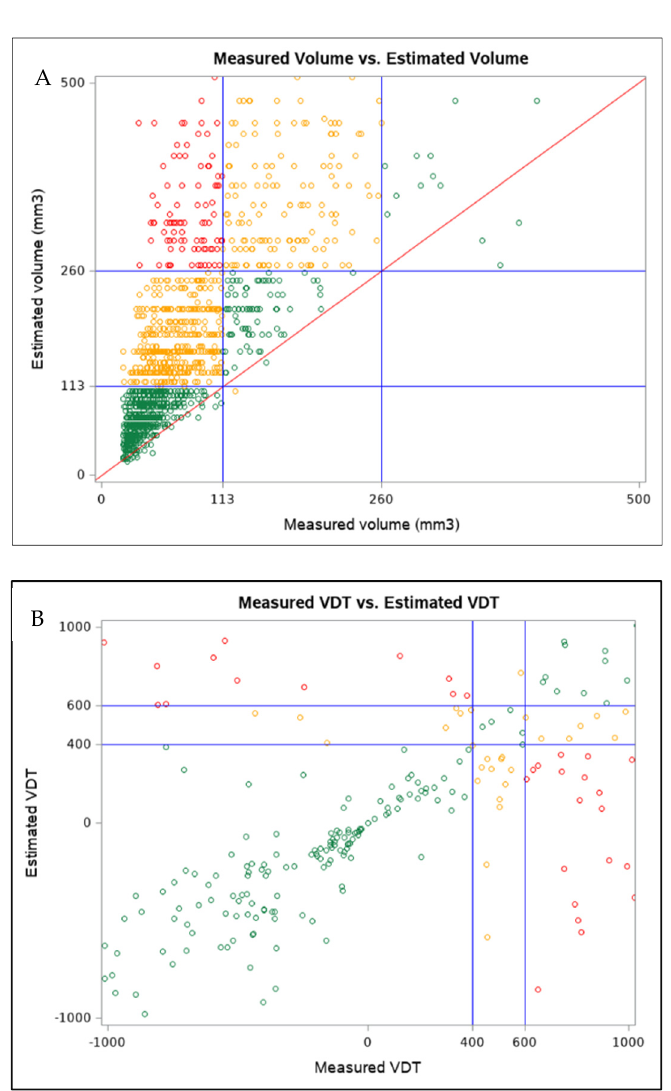
Figure 1. ( A ) Box plot of measured volume and estimated volume for dominant pulmonary nodules, with the volumetric thresholds for negative and positive LDCT outcome highlighted. Only dominant pulmonary nodules with volumes ranging from 3 to 500 mm 3 are reported. ( B ) Box plot of measured volume VDT and estimated volume VDT for dominant pulmonary nodules. Only dominant pulmonary nodules with VDT within − 1000 and 1000 are reported. (Color version online only).